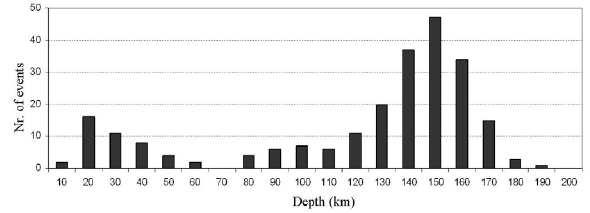
Figure 3. Depth distributions for Vrancea region dataset events (Sandu I., Zaicenco A., 2008) Fig. 3. Depth distributions for the Vrancea region dataset events (Sandu and Zaicenco,